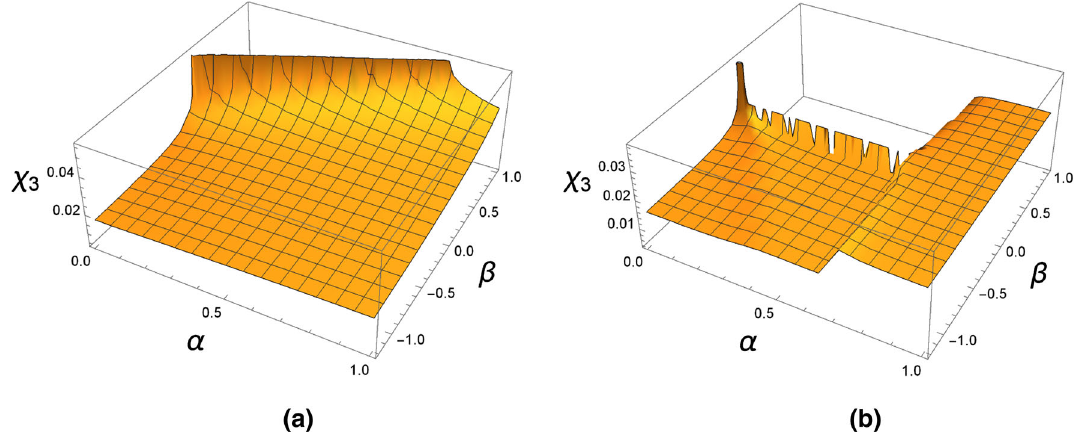
Fig. 3 The figure depicts the snapshots at time t = 0 . 5 of the McVittie event horizon for the (modified) Berthelot and Dieterici equations of state respectively in a ,